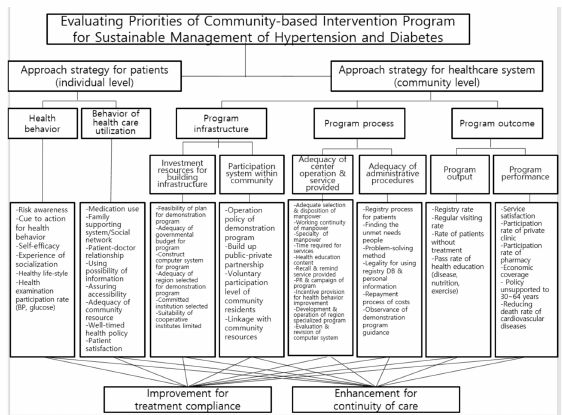
Figure 2. Hierarchical structure of community-based intervention program for sustainable manage- ment of hypertension and diabetes according to the AHP